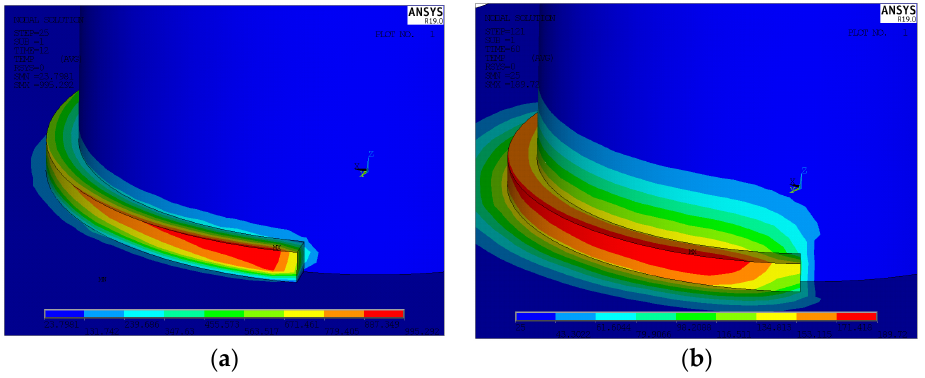
Figure 4. Welding temperature field at a certain moment: ( a ) temperature field at step 25; ( b ) temperature field at step 121. ature field at step